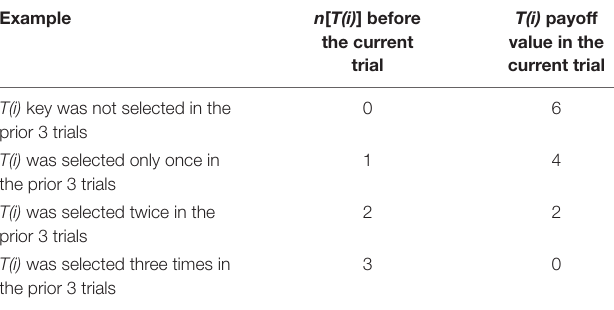
TABLE 1 | The effect of previous choices on the value of treasure keys with k = 3.